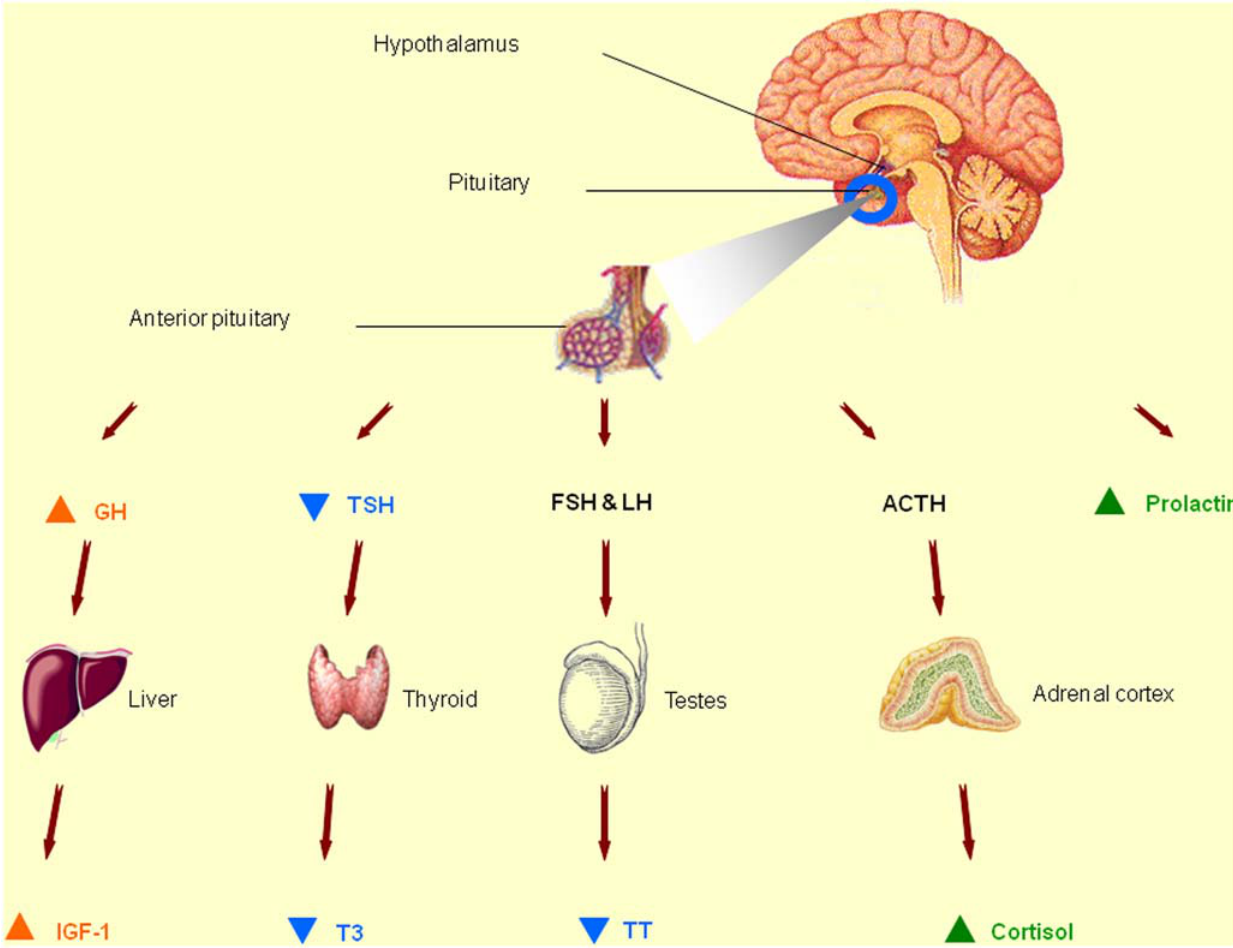
Figure 1. Levels of pituitary and peripheral hormones according to HD stage and comparatively to controls. An orange arrow: early increase in hormone concentration compared to controls. A green arrow: increase in hormone concentration related to an exogenous factor (neuroleptic treatment or stress). A blue arrow: late decrease in hormone concentration related to disease severity. GH, growth hormone; IGF-1, insulin-like growth factor-I; TSH, thyroid stimulating hormone; FT3, free triiodothyronine; ACTH, adrenocorticotropic hormone; LH, luteinizing hormone; FSH, follicle-stimulating hormone; TT, testosterone.